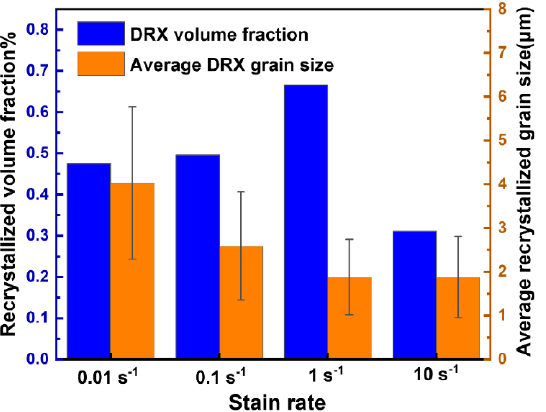
Figure 12. Recrystallized volume fraction and recrystallized grain size at different strain rates.